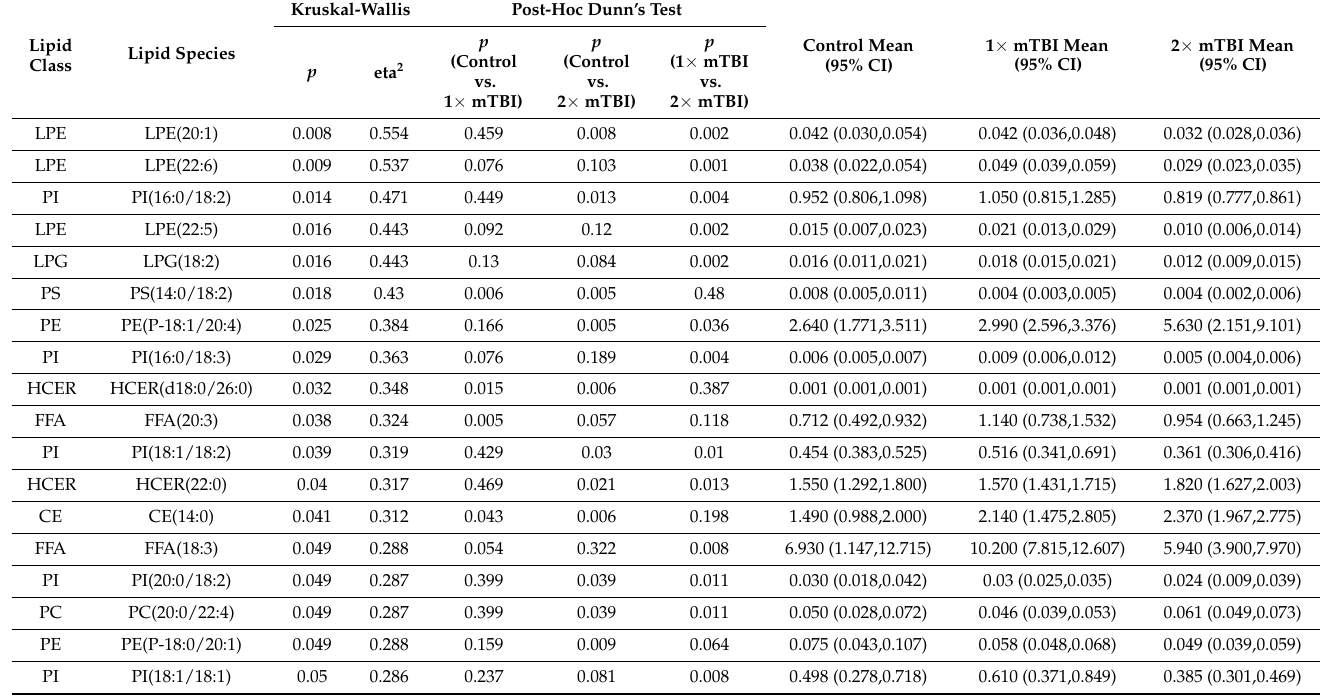
Table 1. Kruskal–Wallis one-way ANOVA on ranks analysis of plasma